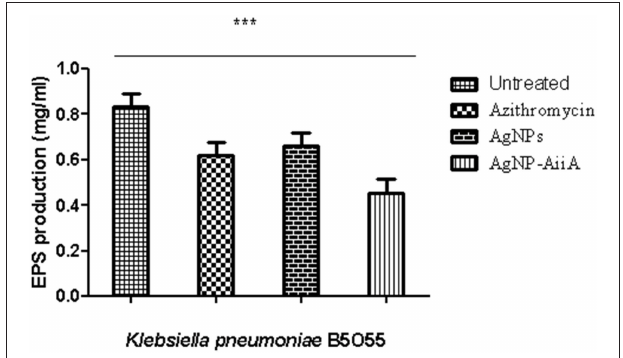
FIGURE 10 | The bar graphs depicts the comparison between production of EPS by K. pneumoniae upon treatment with sub-optimal concentrations of azithromycin, neat AgNPs and AgNP- AiiA complex. To compare all groups one way ANOVA was performed and all the events were found to be significant ( P -value- 0.0115, p < 0.05), ***highly